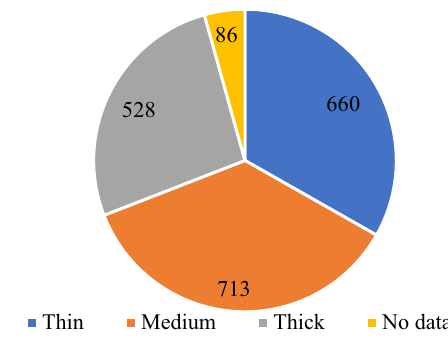
Fig. 7 Summation of each crack width category